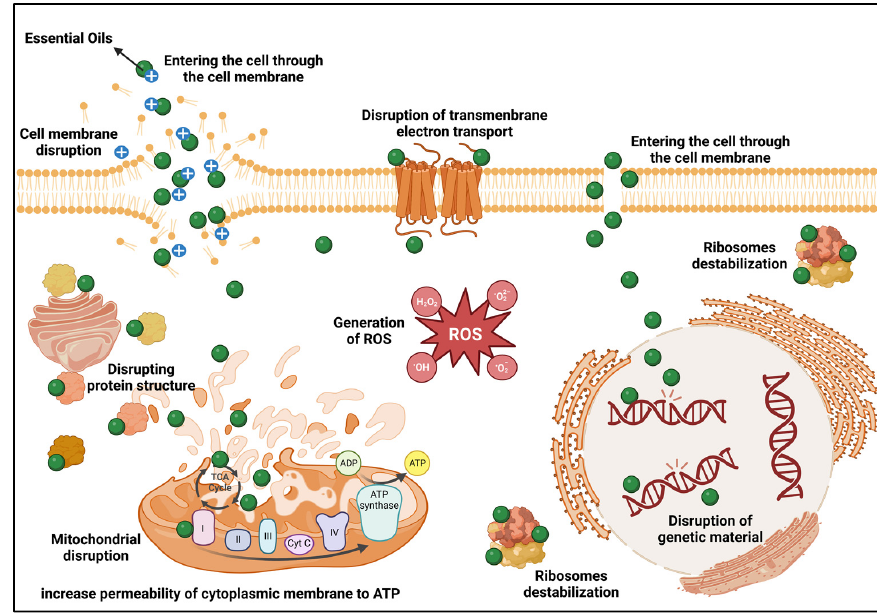
Figure 3. Bacteriostatic mechanisms of essential oils as preservatives for edible mushrooms. Created with BioRender.com.